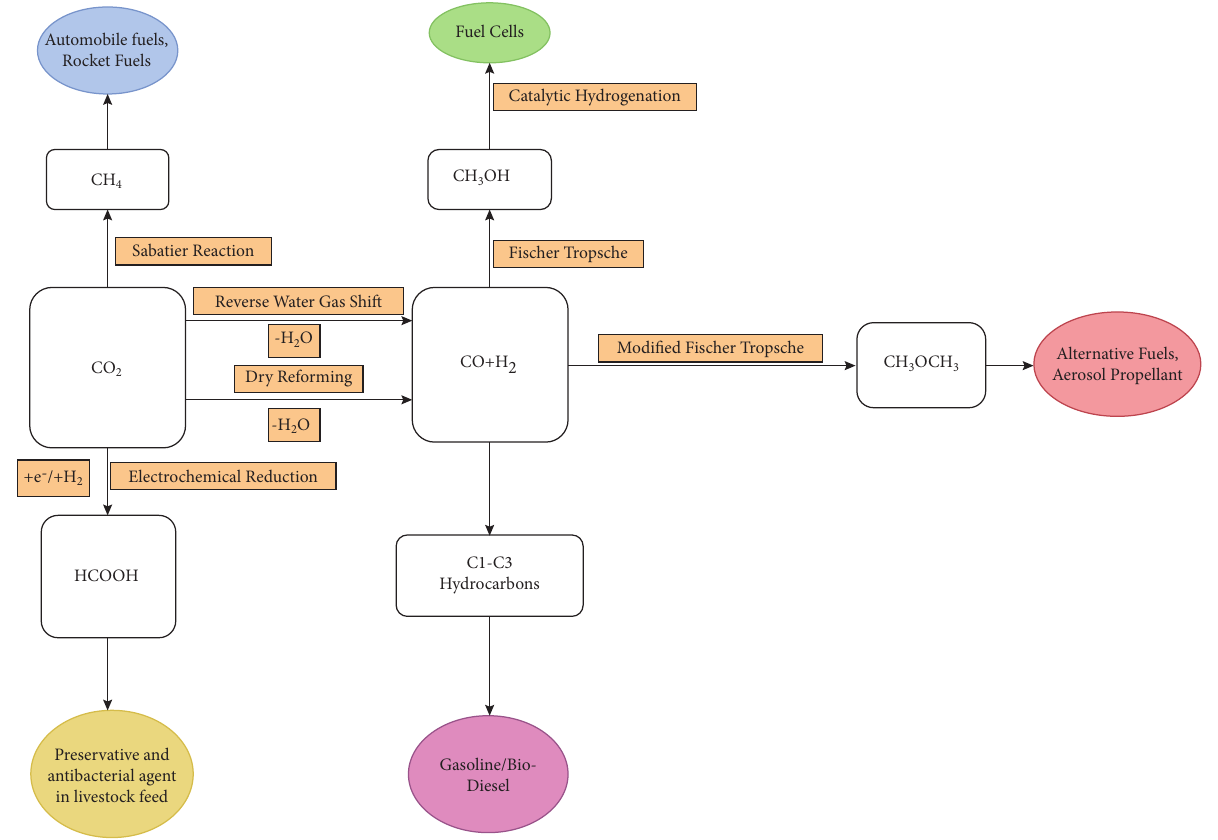
Figure 2: Flowchart describing CO 2 routes for renewable-based